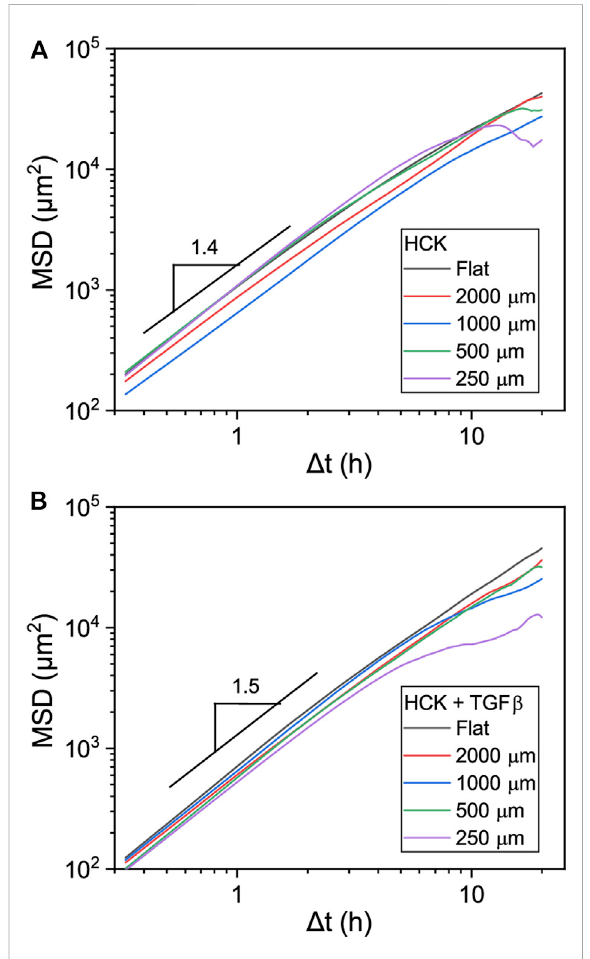
FIGURE 6 Mean squared displacement (MSD) of (A) HCK and (B) HCK + TGF β cells, migrating on cylindrical structures of the indicated sizes. Logarithmic slopes of 1.4 and 1.5 are shown as an indication. Data for D = 125 µm was not analyzed due to the relatively high noise level in the MSD.